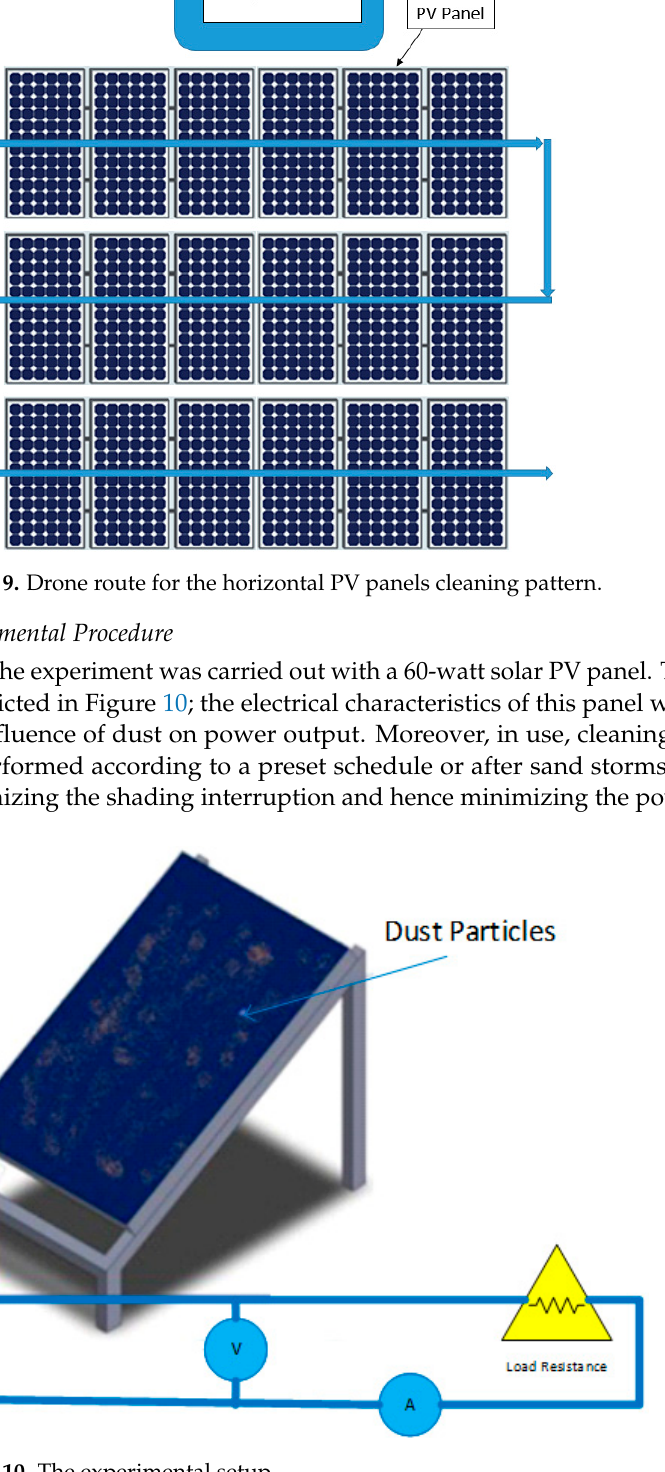
Figure 10. The experimental setup.